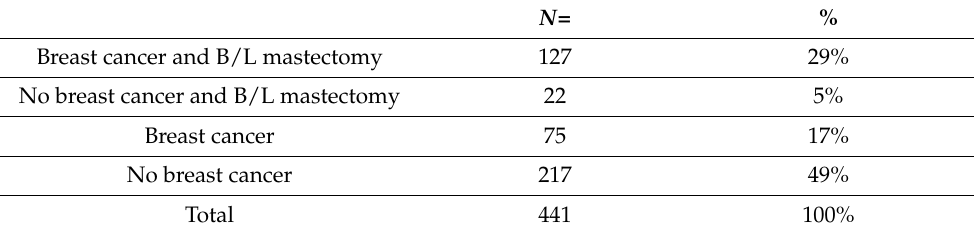
Table 2. History of breast cancer and mastectomy in women carrying PVs in eight breast cancer genes. N = % Breast cancer and B/L mastectomy 127 29% No breast cancer and B/L mastectomy 22 5% Breast cancer 75 No breast